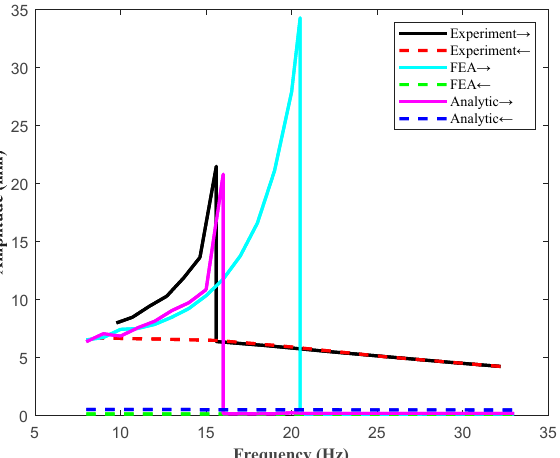
Figure 11. Vibration amplitudes of the bistable plates under higher-level sinusoidal excitation at different frequencies.